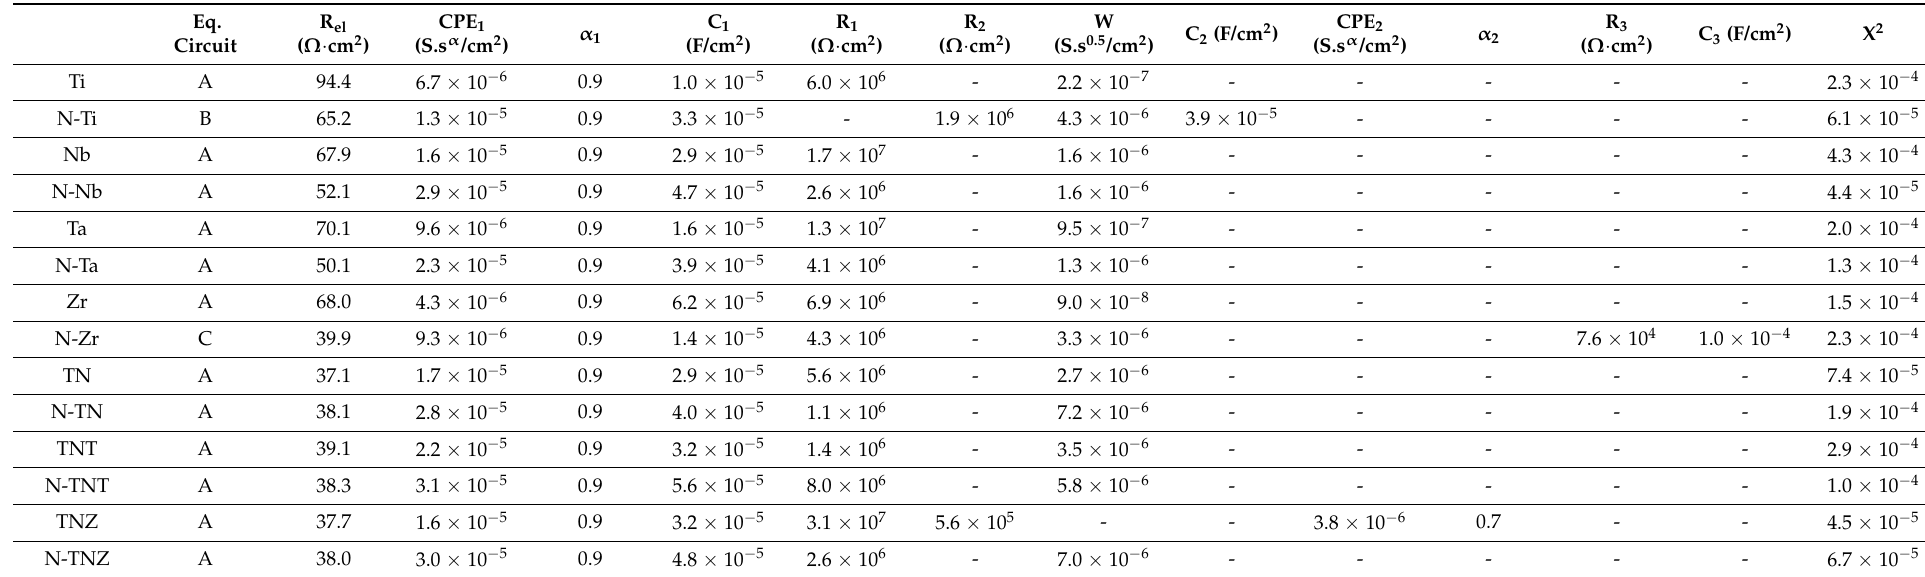
Table 4. Values of equivalent circuit used for the EIS spectra, C 1 was